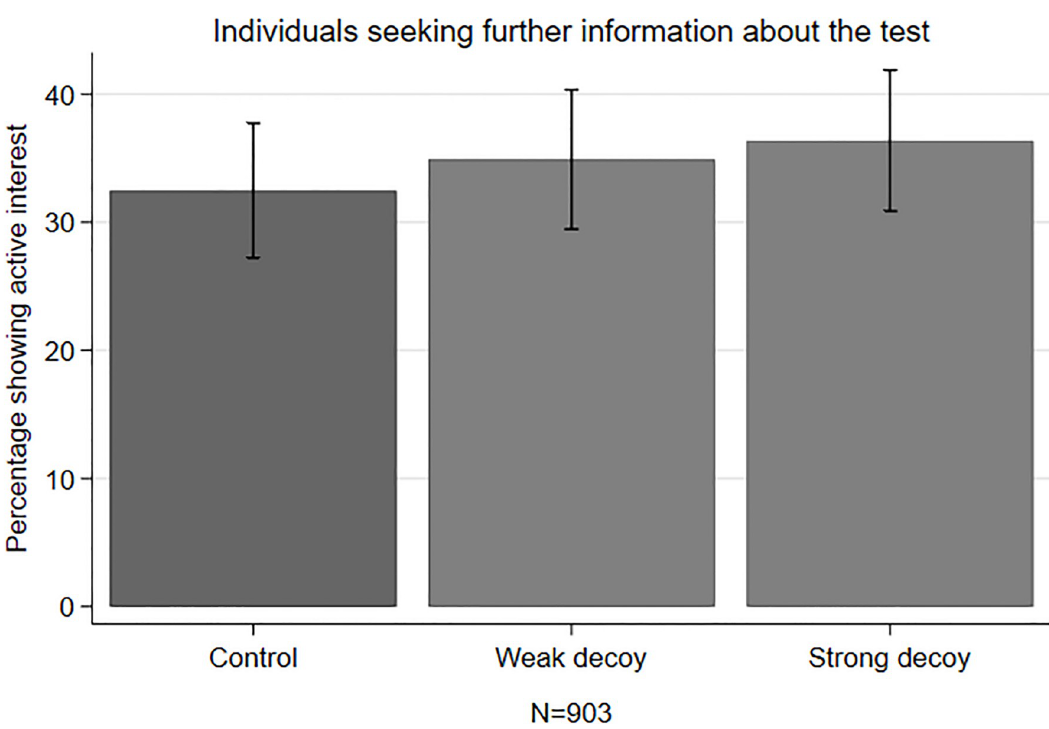
Fig 7. Mean percentage of seeking more